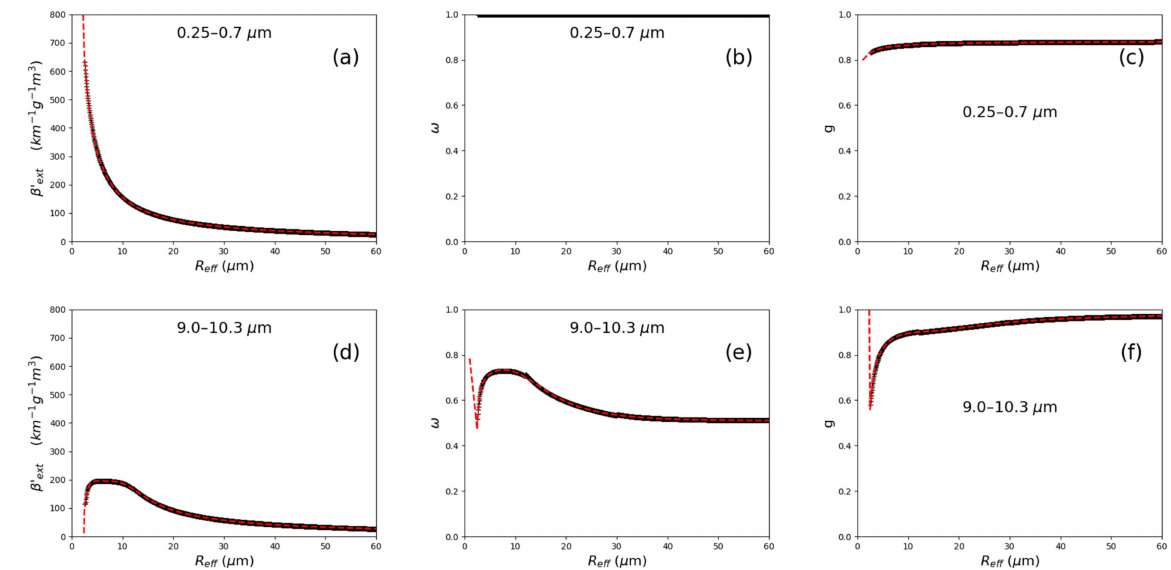
Figure 4. Parametrizations for volume extinction coefficient divided by the liquid water content (LWC) ( a , d ), single scattering albedo ( b , e ), and asymmetry factor ( c , f ). The upper and lower rows refer to wavelengths of 0.25–0.7 µ m (SW) ( a – c ) and 9.0–10.3 µ m (LW)( d – f ) intervals respectively. The black line is composed of HS93 original data spectrally averaged for our wavelength intervals and the red dashed line denotes the parametrization fit model. As can be seen from the plots, the fit is invalid for an effective radius smaller than 2.5 µ m. These fits showed the correct asymptotic behavior up to 7000 µ m (not shown here).